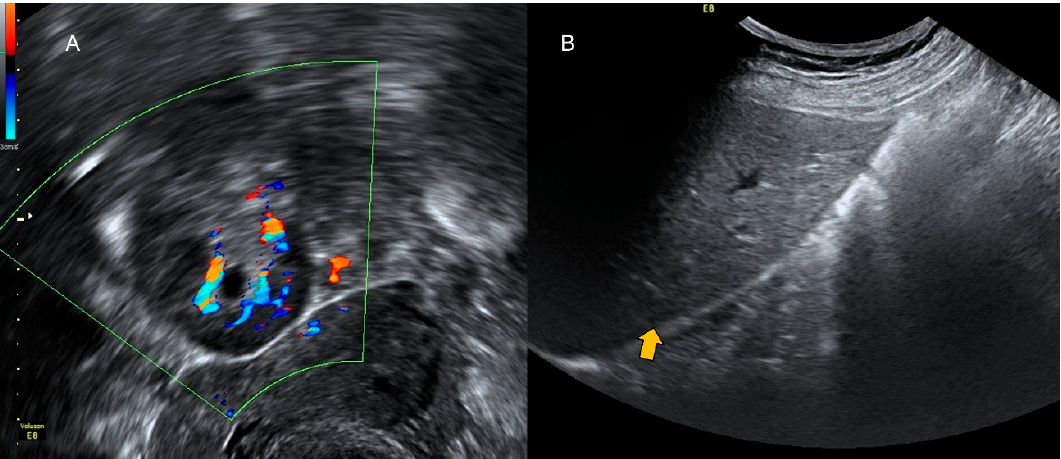
Figure 17. Color Doppler transvaginal ultrasound shows the vascularization of an ectopic kidney ( A ). Transabdominal ultrasound in the same patient demonstrates the presence of the liver (yellow arrow) and the absence of the orthotopic kidney ( B ).